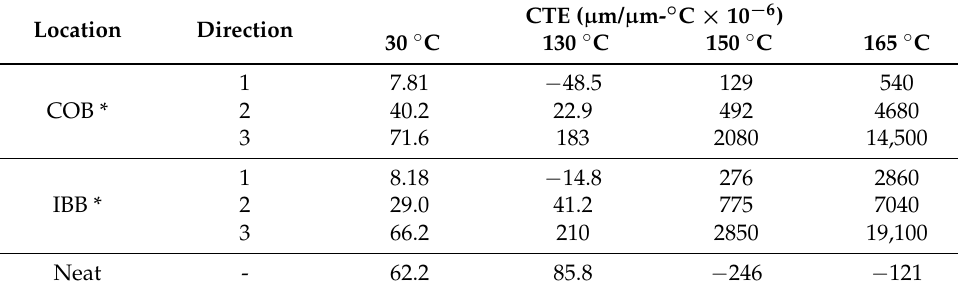
Table 7. CTE values for CF/PC and PC ( T g = 147–150 ◦ C). Location